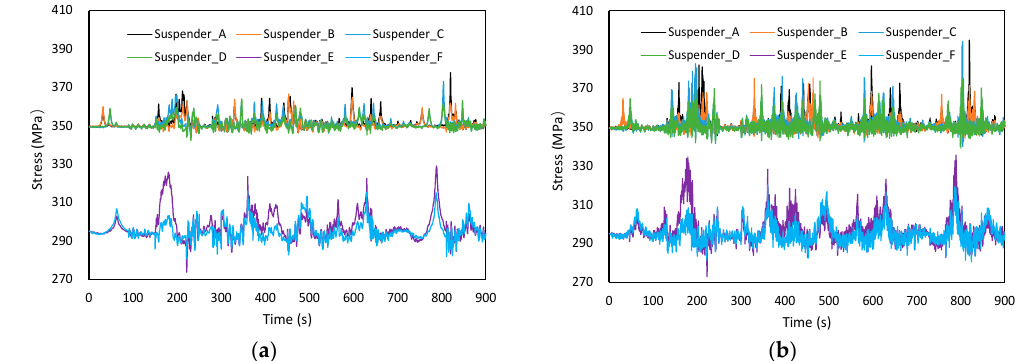
15 of 20 Figure 16. Time-dependent laws of suspender stress in different driving lanes. ( a ) Suspender A, ( b ) Suspender B, ( c ) Suspender C, ( d ) Suspender D, ( e ) Suspender E, ( f ) Suspender F. 4.4. Fatigue Load Calculation Assuming that the total daily traffic volume in bridge follows the Poisson process with a parameter 𝜆 , the WIM data in July 2016 is adopted to estimate the parameter 𝜆 considering no legal holiday in the month. It can be calculated that 𝜆 = 34,390 per day. According to the fatigue load spectrum defined in Section 4.1, the traffic flow per second for these three vehicle types was 𝜆 (cid:2913)(cid:2911)(cid:2928)_(cid:2869).(cid:2873) = 0.26, 𝜆 (cid:2930)(cid:2928)(cid:2931)(cid:2913)(cid:2921)_(cid:2869)(cid:2873) = 0.06, 𝜆 (cid:2930)(cid:2928)(cid:2911)(cid:2919)(cid:2922)(cid:2915)(cid:2928)_(cid:2873)(cid:2868) = 0.08 . Then, the entering time for each vehicle can be simulated by the Poisson process and the simulation program was designed in MATLAB. Similarly, the speed and driving lane for each vehicle can also be simulated based on the definition in Figures 12 and 13.